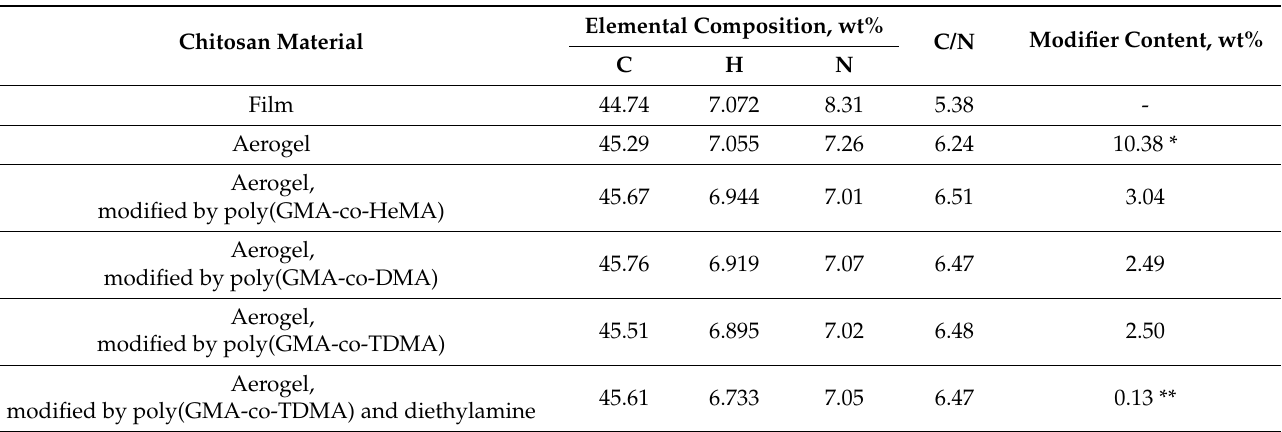
Table 2. Results of elemental analysis of chitosan materials before and after modification (by CHNOS